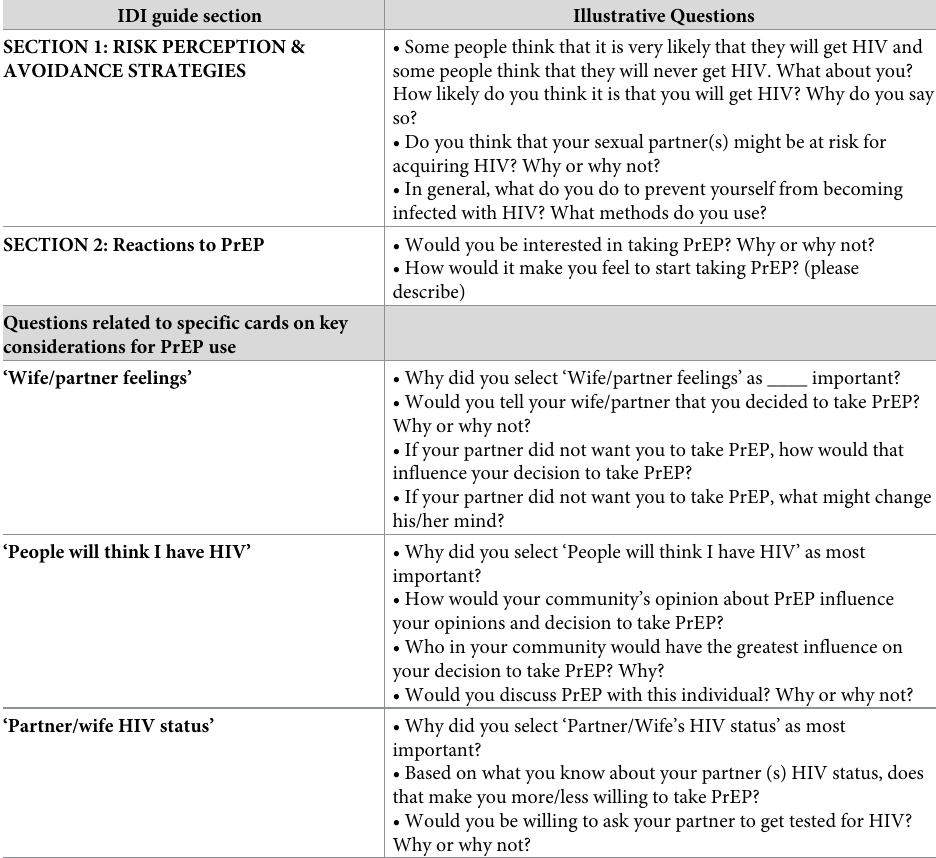
Table 1. Sample of in-depth interview guide questions asked to AGYW and male